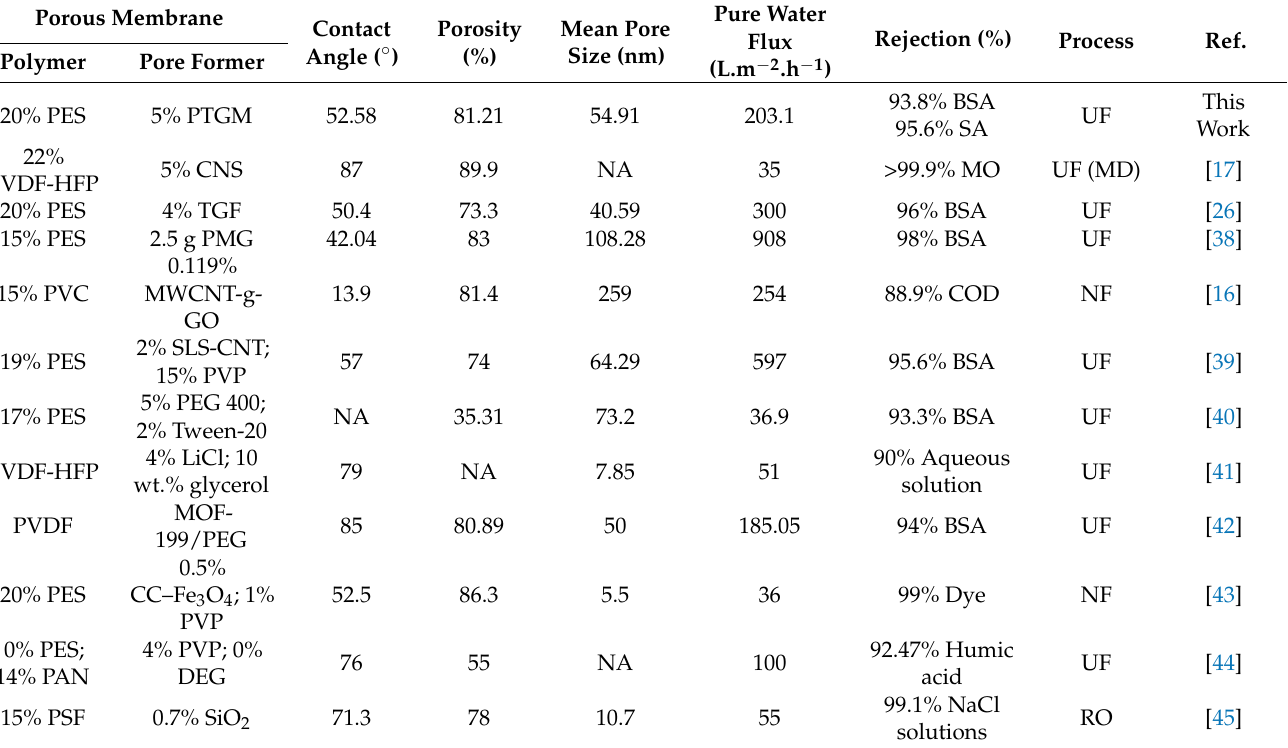
Table 2. Comparison of the results observed by this work with the recent works found in the literature. Porous